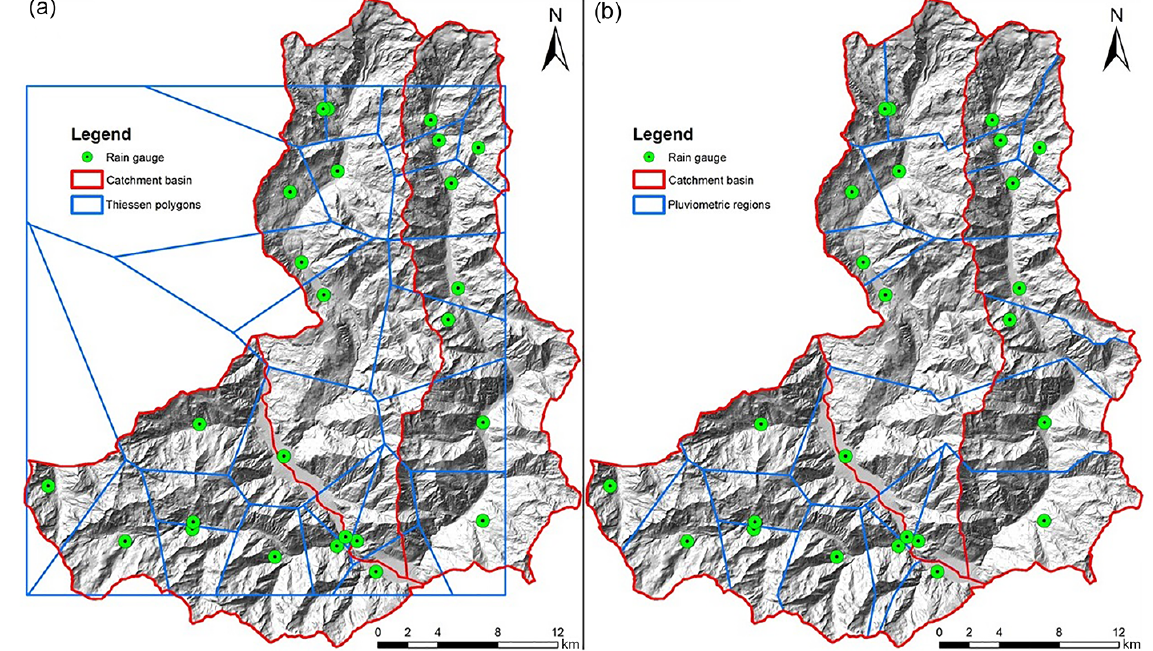
Figure 3. Comparison of Thiessen polygons methodology; (a) simple and (b) modified according to the catchment basins